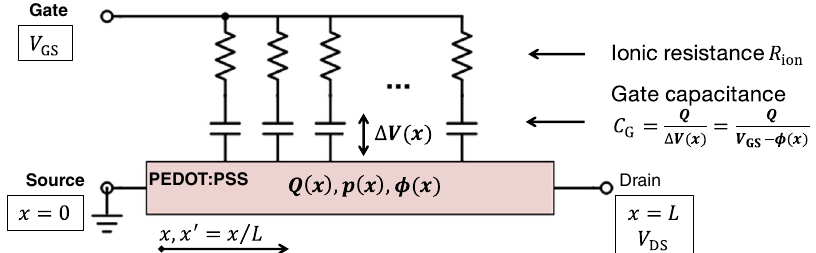
Fig. 1 Equivalent circuit used in capacitive device models. As fi rstly proposed by Bernards and Malliaras 8 , a gate capacitance C G is used to calculate the ion concentration Q inside the transistor channel. Based on this assumption, an analytical solution for the hole concentration p ( x ), the channel potential Φ ( x ), and the drain current I D as a function of the gate and drain potential V GS and V DS can be